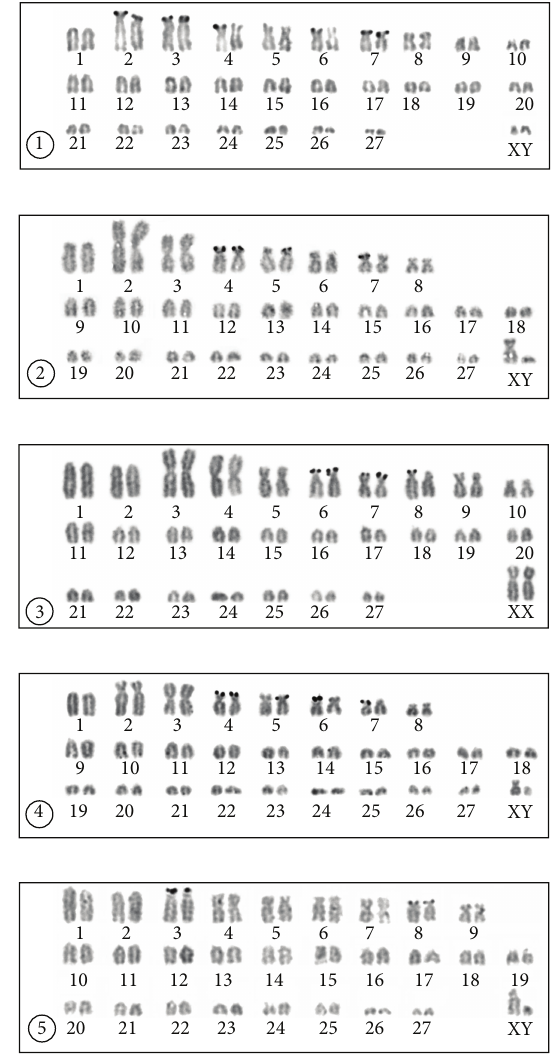
Figure 4: Silver stained karyotypes of specimens of Nannospalax leucodon from Babaeski (1) and N. xanthodon from Kula (2), Alas¸ehir (3), Yılanlı (4), and G¨ulek